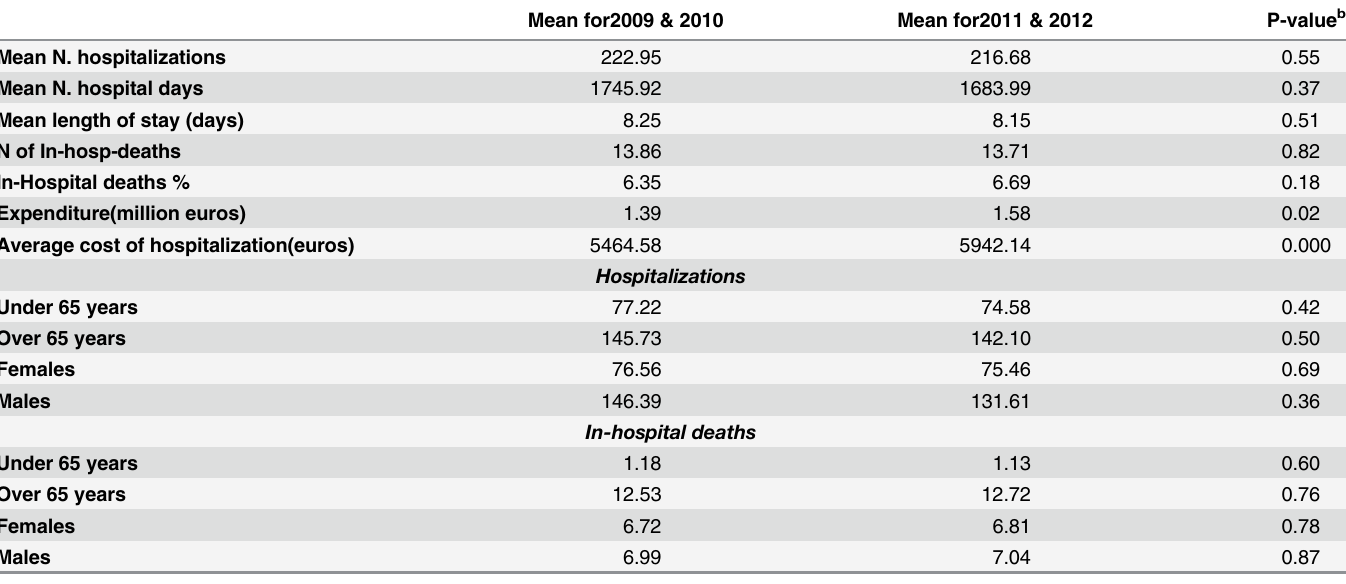
Table 1. Acute Myocardial Infarction in Italy: descriptive statistics and trends of the main variables a